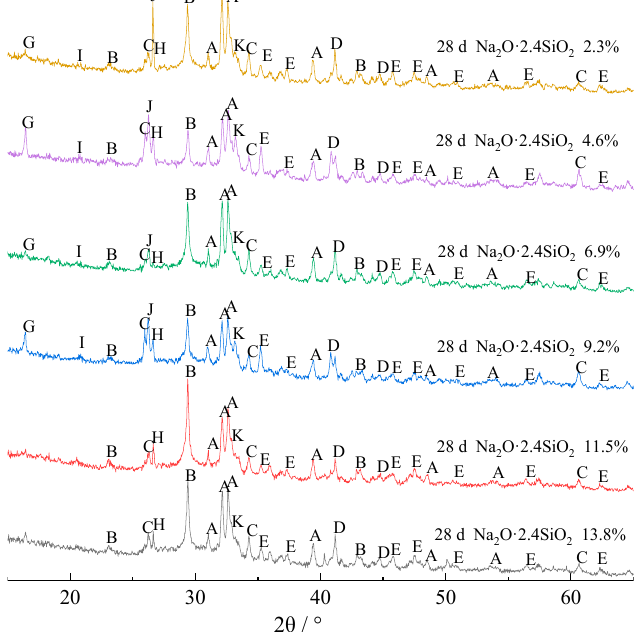
Figure 3. XRD patterns of composite alkali-activated cementitious materials after curing for 28 days. A, β -dicalcium silicate ( β -2CaO · SiO 2 ); B, calcite (CaCO 3 ); C, lawsonite (CaO · Al 2 O 3 · 2SiO 2 · 2H 2 O); D, C-S-H(xCaO · SiO 2 · (m+x − 2)H 2 O);E,boggsite(Na 3.7 Ca 7.4 Al 18.5 Si 77.5 O 192 · 74H 2 O);G,mullite(3Al 2 O 3 · 2SiO 2 ); H, tetranatrolite ((Na,Ca) 2 (Si,Al) 5 O 10 · 2H 2 O); I, beidellite (Na 0.3 Al 2 (Si,Al) 4 O 10 (OH) 2 · 2H 2 O); J, quartz (SiO 2 ); K, wairakite (CaO · Al 2 O 3 · 4SiO 2 · 2H 2